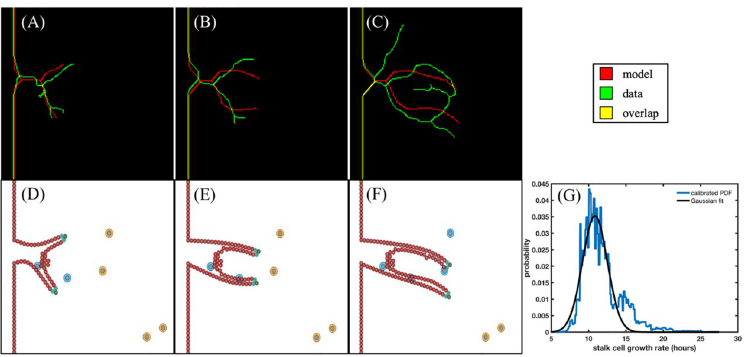
Fig 8. Local region 1: Calibration of stalk cell growth rate. Fig 8A-C show the centerlines calculated from the model best fit (red), the data (green), and the overlap (yellow) on day 3 (used to inform the initial conditions), day 5, and day 7 (used to calibrate the stalk cell growth rate). The ABM is shown in Fig 8D-F with tip cells in green, stalk cells in cyan, endothelial cells in red, tumor cells releasing VEGF in orange, and tumor cells not releasing VEGF in blue. In Fig 8G, we show the calibrated PDF and the Gaussian fit of the stalk cell growth rate. The best fit model recapitulates the general structural features of the data without allowing additional sprouts to form. We also note that from day 7 (depicted in Fig 8F) to day 9, only the two tumor cells in the bottom right of the domain continue to release VEGF, guiding the sprout migration to the bottom right of the domain.